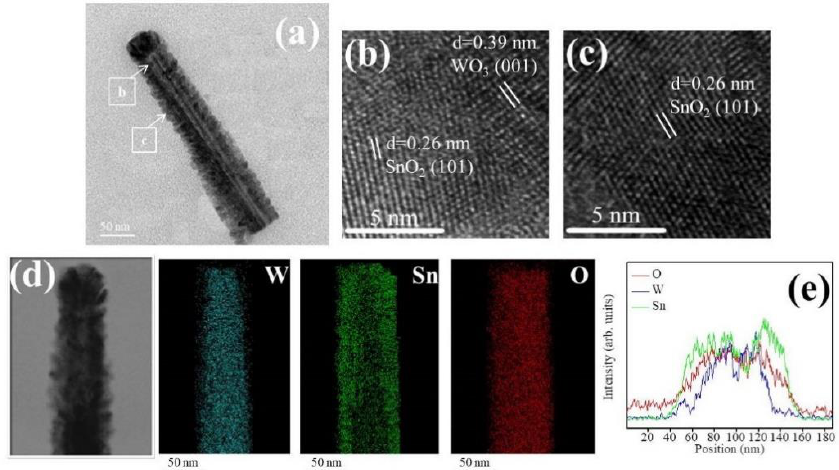
Figure 4. ( a ) Low magnification TEM image of a WS-2 nanorod. ( b , c ) HRTEM images of the nanorod taken from different regions. ( d ) W, Sn, and O elemental mapping images of the nanorod. ( e ) Energy-dispersive X-ray spectroscopy (EDS) line-scanning profiles across the nanorod.